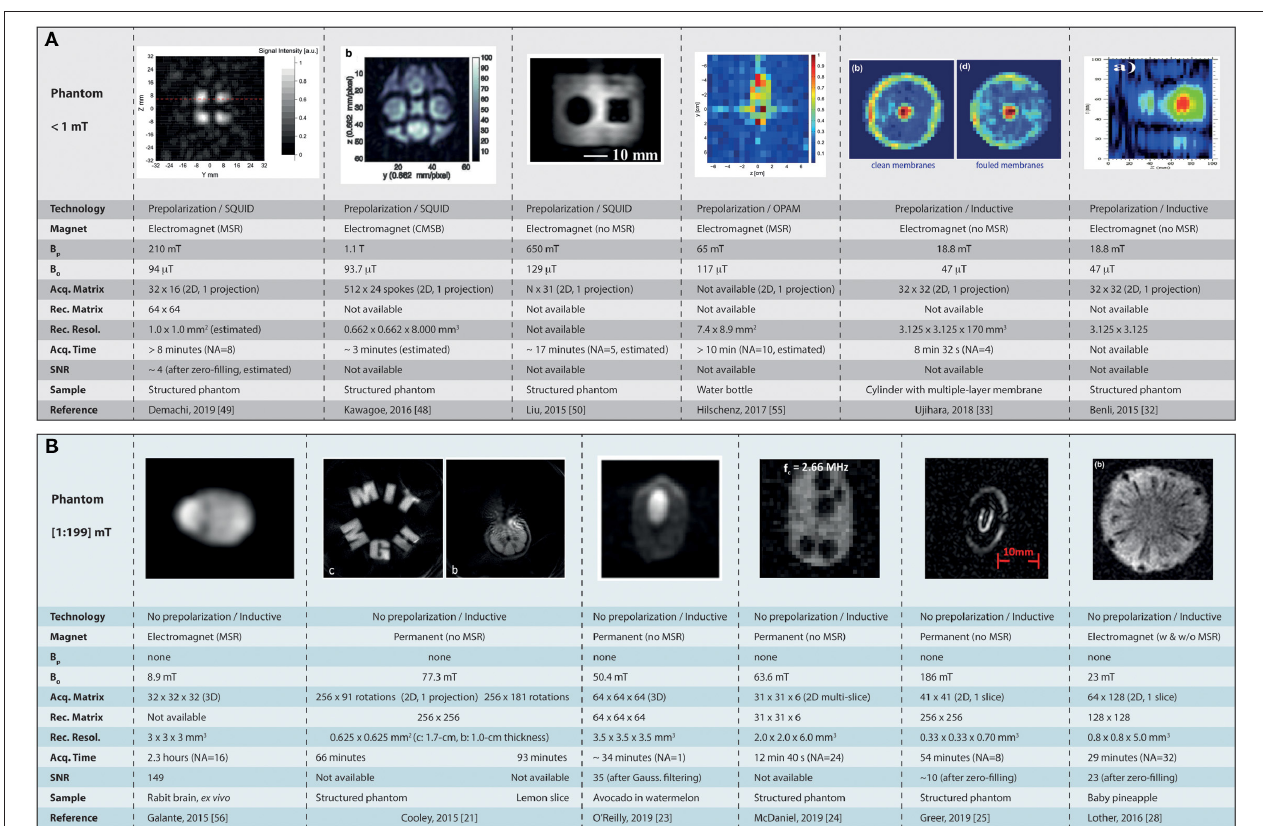
FIGURE 3 | Summary of the current landscape of low-field MR imaging in phantoms. (A) Shows the major achievements obtained at ultra-low field (micro tesla range) in combination with SQUID detectors, and (B) the images obtained in the mT range (from 1 to 199 mT). MSR, magnetically shielded room; CMSB, compact magnetically shielded box; B p , polarization field; NA, number of signal averaging. Images reused with permission from Cooley et al. [21], O’Reilly et al. [23], McDaniel et al. [24], Greer et al. [25], Lother et al. [28], Benli et al. [32], Ujihara et al. [33], Kawagoe et al. [48], Demachi et al. [49], Liu et al. [50], Hilschenz et al. [55]. Images reused from Galante et al. [ 56], held under Creative Commons License CC-BY